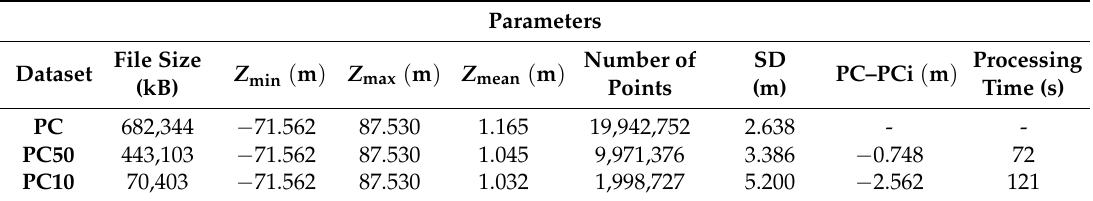
Table 3. Characteristics of obtained datasets after the OptD-single-MLS method for 3D PC.